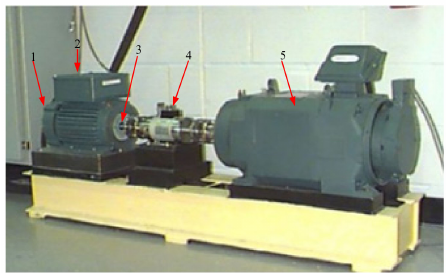
Figure 1. CWRU rolling bearing test bench [21]. 1. Fan end bearings; 2. Motor; 3. Drive end bearing;